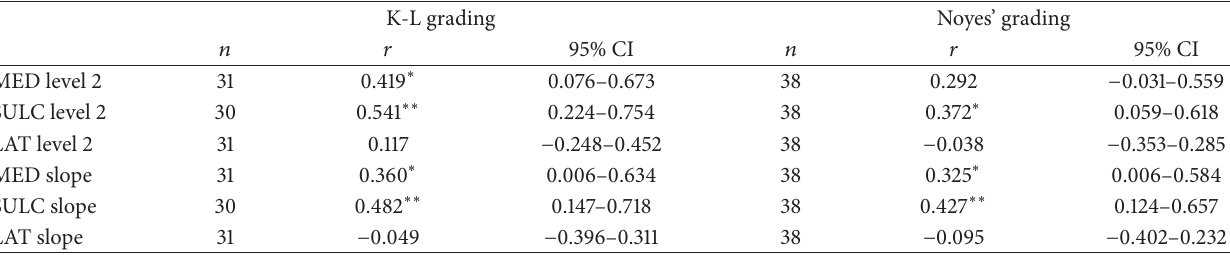
Table 1: Spearman’s rank correlations ( 𝑟 ) between ultrasound medial (MED), sulcus (SULC), and lateral (LAT) bone depth level 2 intensities and intensity slopes and radiographic K-L grading or arthroscopic Noyes’